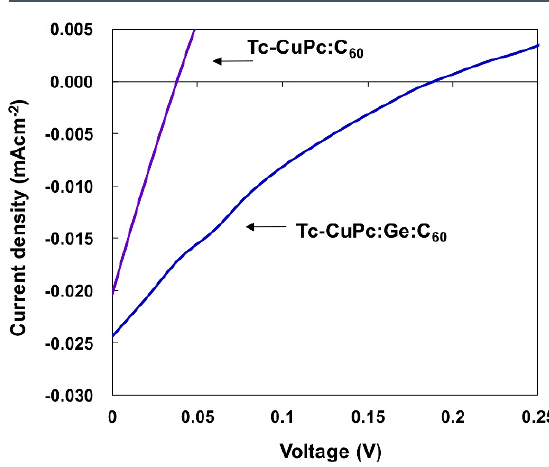
Figure 2. Measured J-V characteristic of Tc-CuPc:Ge:C 60 and Tc- CuPc:C 60 bulkheterojunction solar cells under illumination.